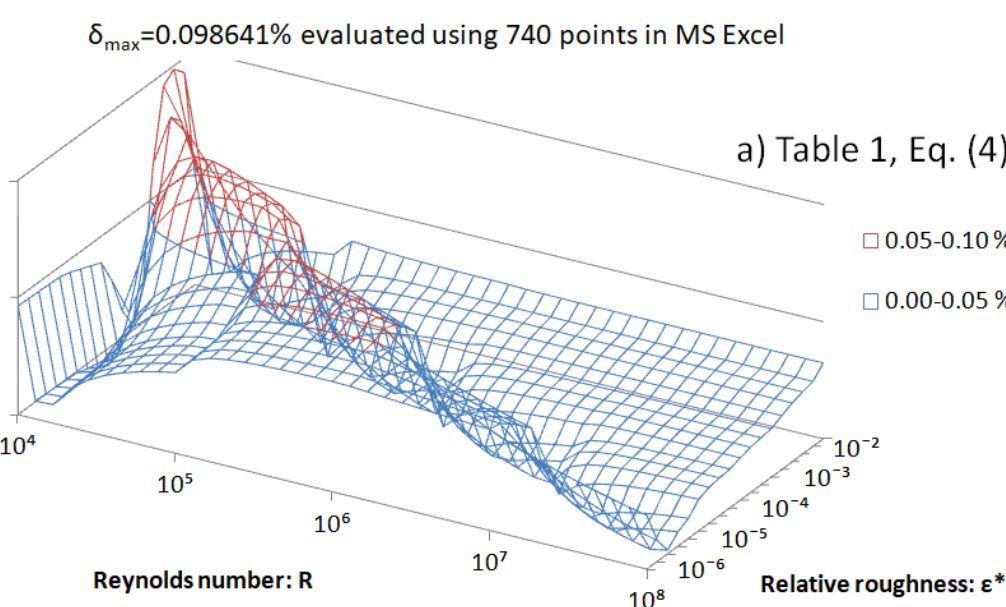
Figure 1. Distribution of the relative error by the proposed explicit approximation of the Colebrook’s equation; Equation (4) from Table 1 using a limited number of 740 sample points.